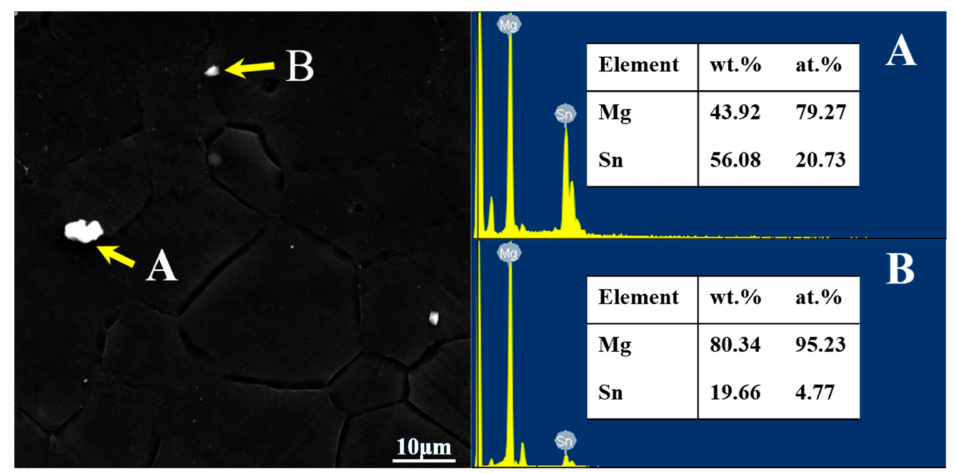
Figure 6. The scanning electron microscopy (SEM) and EDS results of the main phase in the as-extruded AT63 alloy. ( A ) and ( B ) are Mg 2 Sn with different